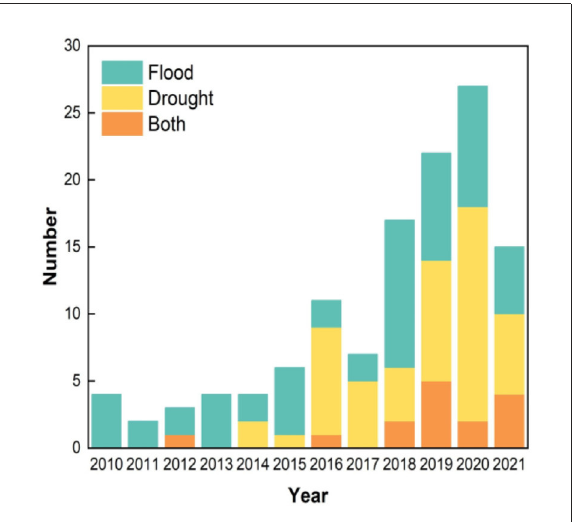
FIGURE6 The considered hazard type(s) per publication year for the reviewed